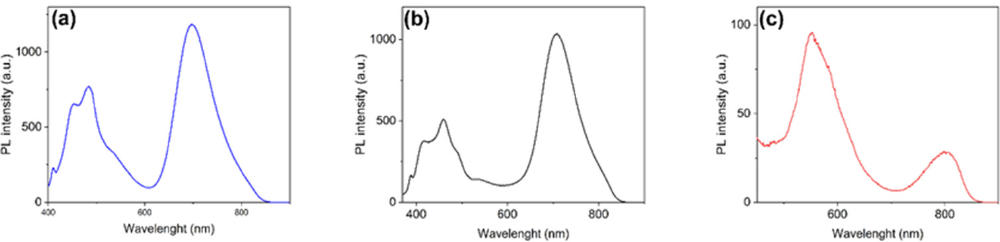
Figure 6. PL spectra of 1a – c in toluene (0.01 mM): ( a ) 1a ( λ exc = 365 nm); ( b ) 1b ( λ exc = 347 nm); ( c ) 1c ( λ exc = 372 nm).